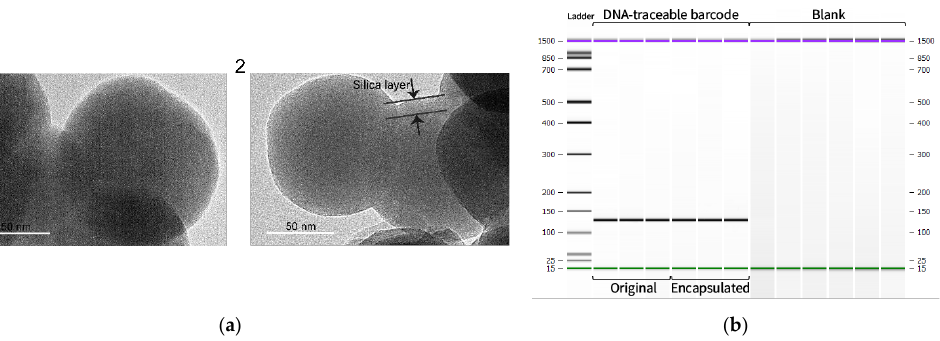
Figure 5. Characterization and identification of DNA-traceable barcode encapsulated silica particles. ( a ) 1: Transmission electron microscopy image of SiO 2 particles without encapsulated DNA-traceable barcode. 2: Transmission electron microscopy image of DNA/SiO 2 particles. Scale bar, 50 nm. The silica layer has a thickness of 12 nm, and it protects the nucleic acid from ROS and heat. ( b ) Capillary electrophoresis graph obtained from plasmid DNA before encapsulation and after release from DNA/SiO 2 particles. Purple lines are upper marker, green lines are lower